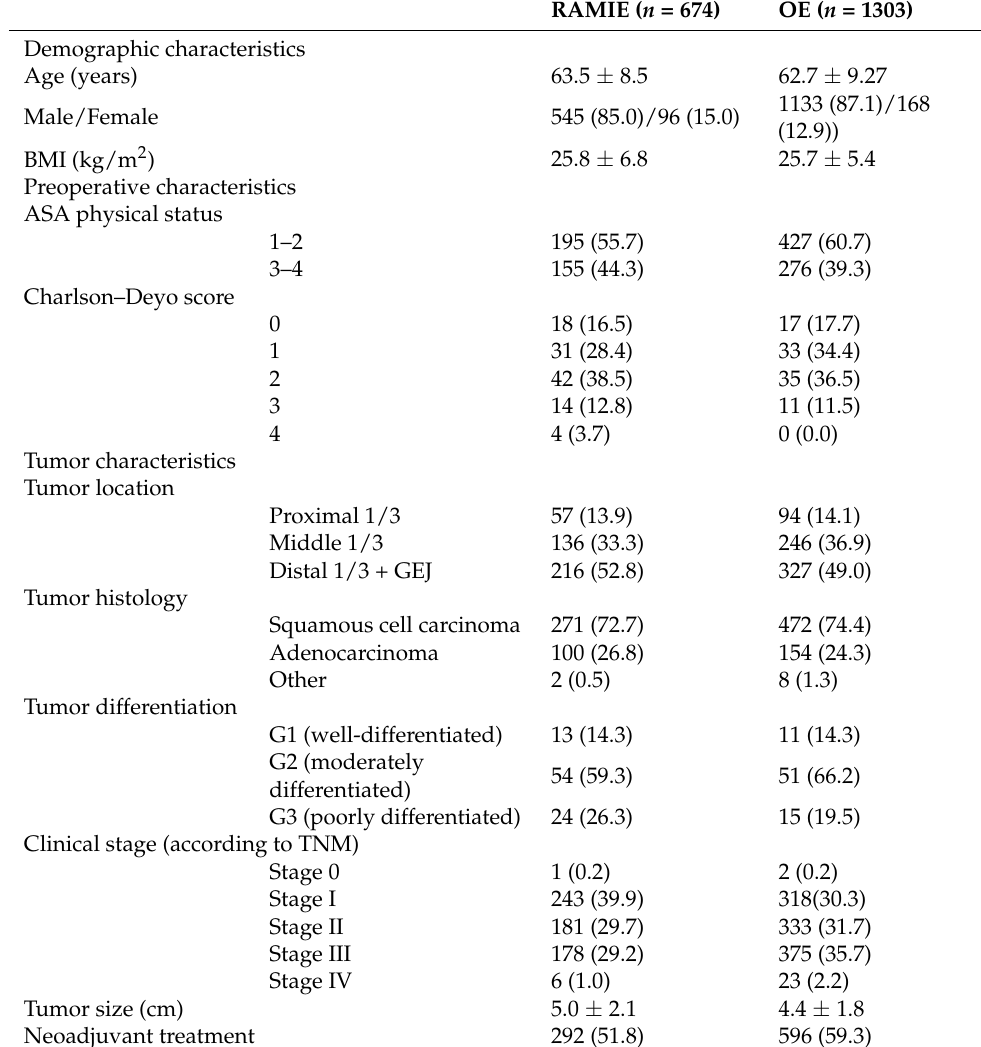
Table 2. Demographic, preoperative, and tumor